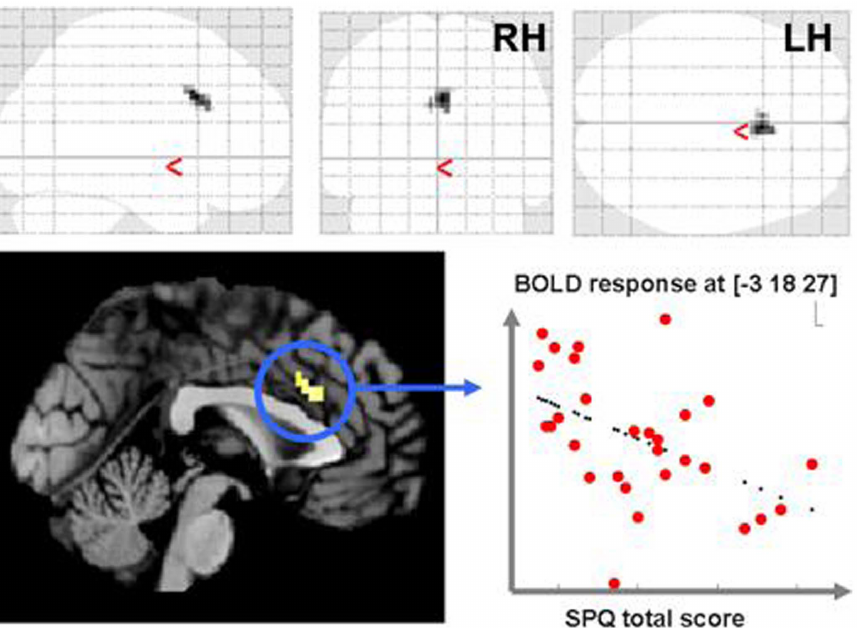
Figure 3. negative correlation between BOLD response at MNI [ 2 3 18 27] and SPQ total score. ACC activation in the cluster with strongest underactivation relative to controls (see figure 2) shows negative correlation with the schizotypal personality questionaire total score. Ironic sentences . visual baseline. For illustrative purposes, threshold of p , 0.005, ext. 10 voxels are used.